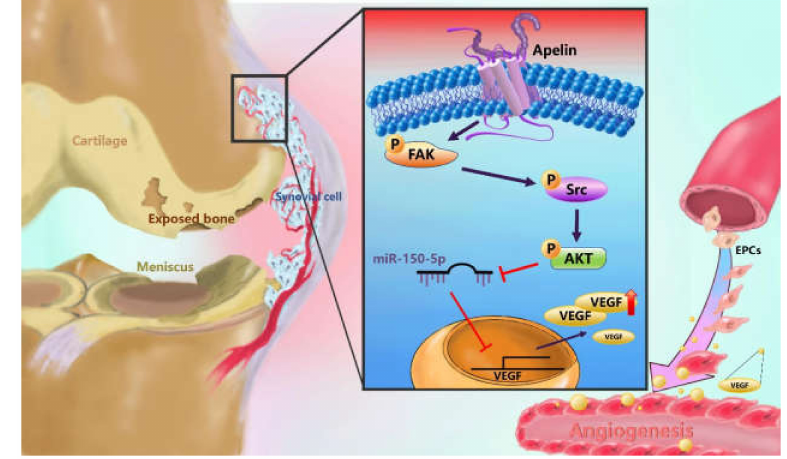
Figure 8. Schematic diagram summarizes the mechanism whereby Apelin upregulates VEGF expression in human synovial fibroblasts. APLN induces VEGF expression and angiogenesis through the FAK / Src / Akt signaling cascade and reduces miR-150-5p expression in OASFs. FAK: focal adhesion kinase; VEGF: vascular endothelial growth factor; EPCs: Human endothelial progenitor